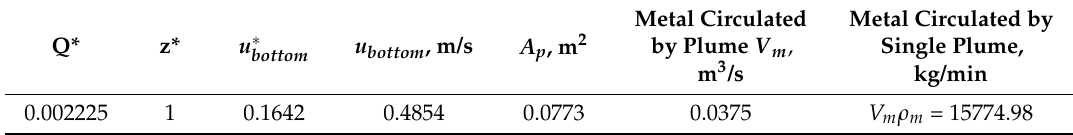
Table A2. Calculation of metal circulation by single